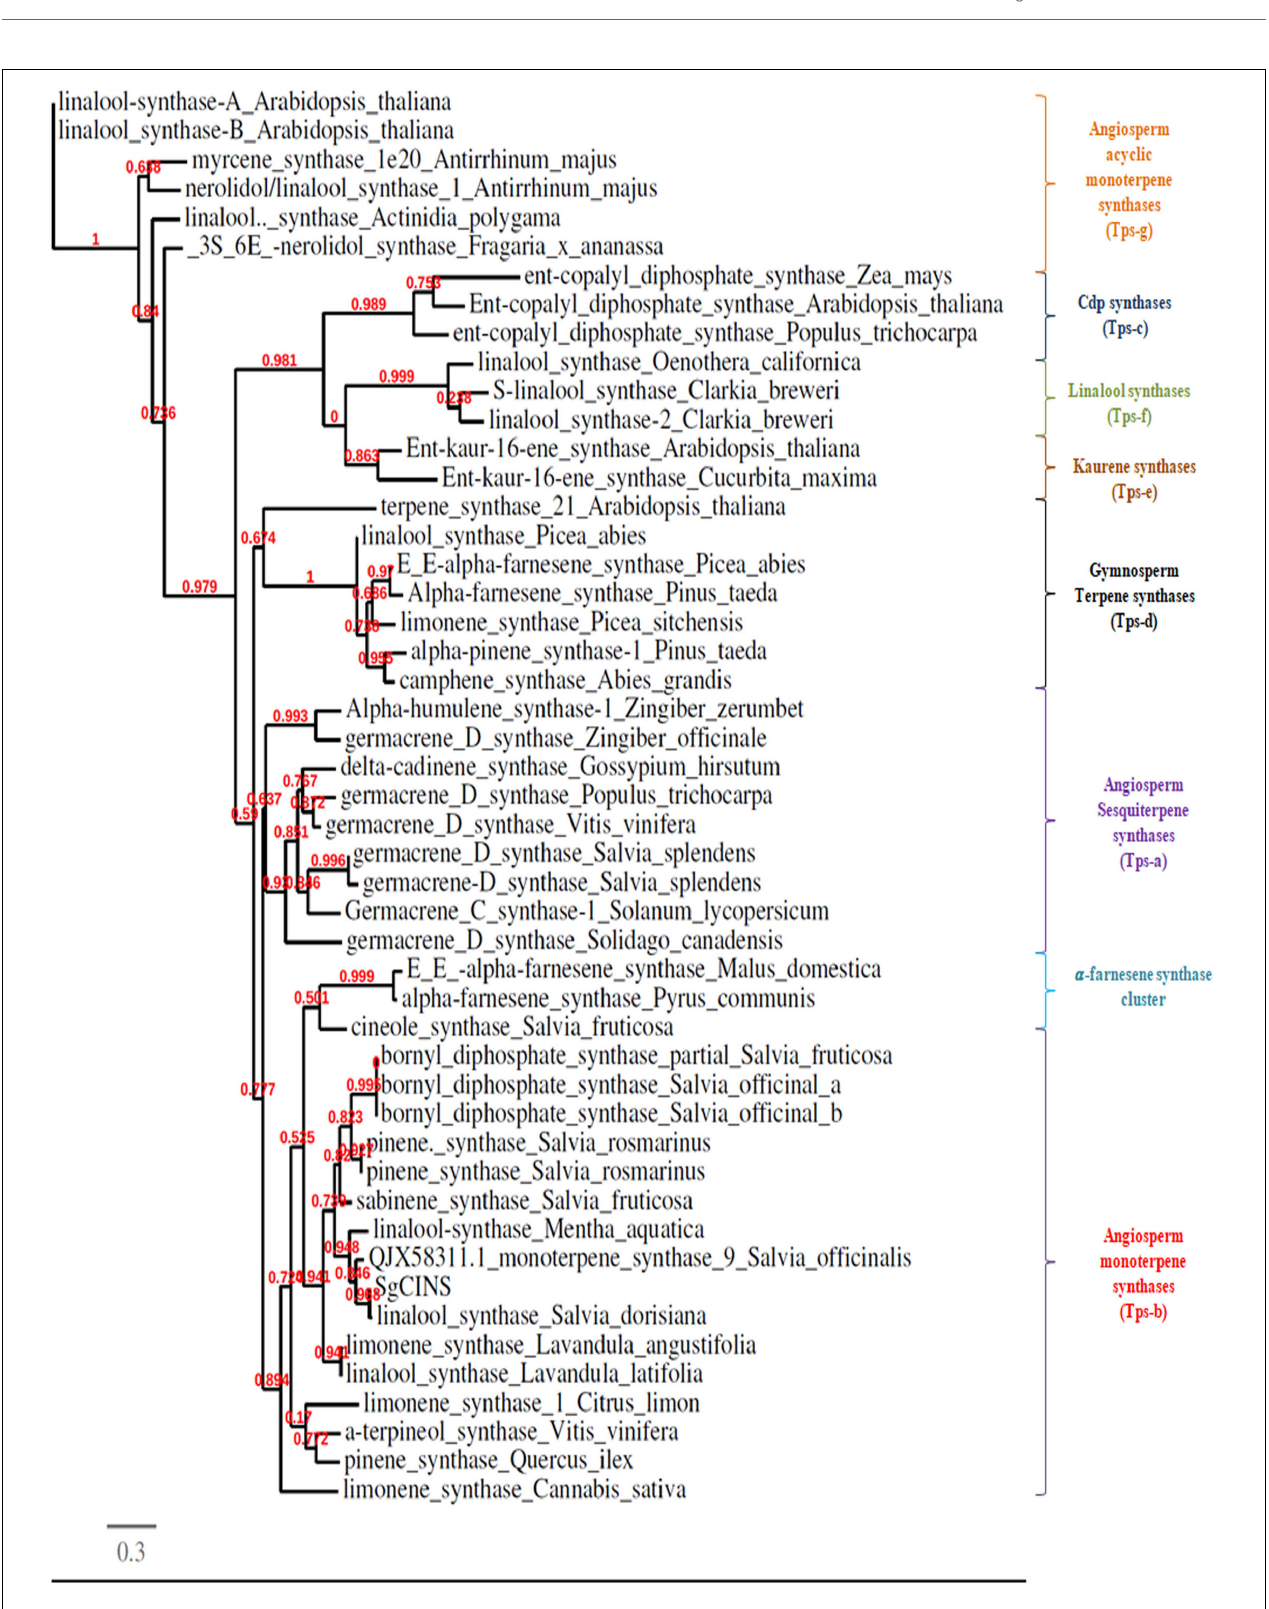
FIGURE 1 | Phylogenetic tree of 1,8-cineole synthase ( SgCINS ) gene from S. guaranitica with selected terpene synthases genes from other plant species. Bootstrap values based on maximum likelihood are reported at the nodes.